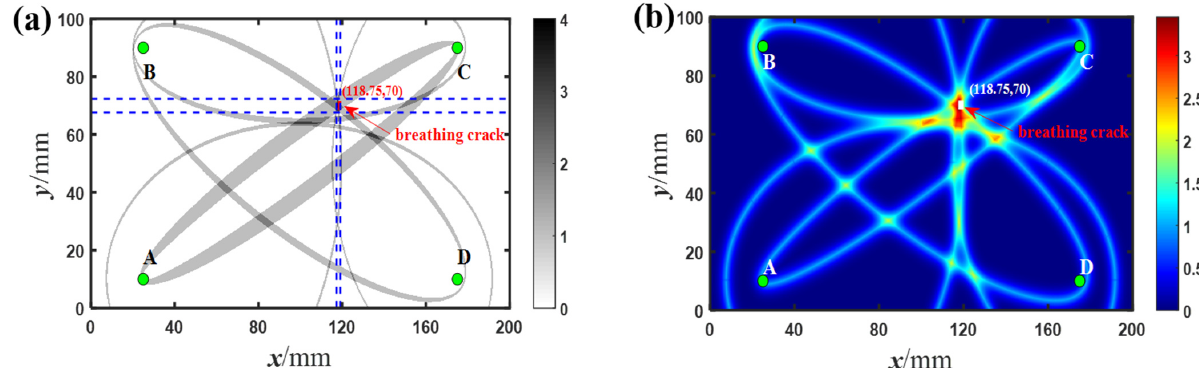
Figure 13. Localization and imaging of the breathing crack at the coordinates (118.75, 70) with nonlinear Lamb waves using ( a ) modified ellipse method; ( b ) probability-based diagnostic imaging.